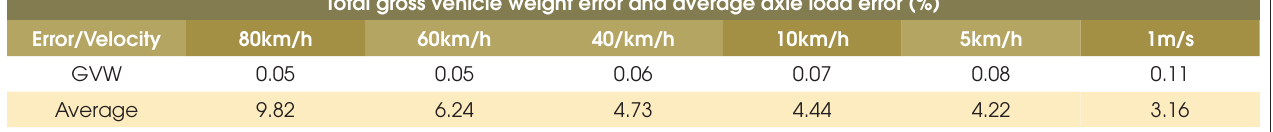
Table 3 – Total gross weight error and average axle load error for varying velocities